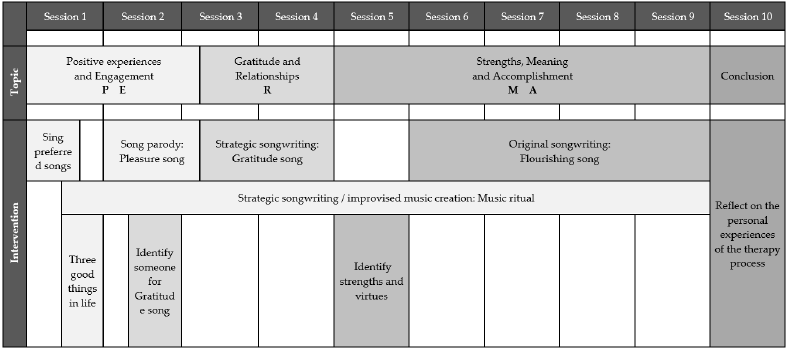
Figure 1. Overview focus and applied intervention of each session.